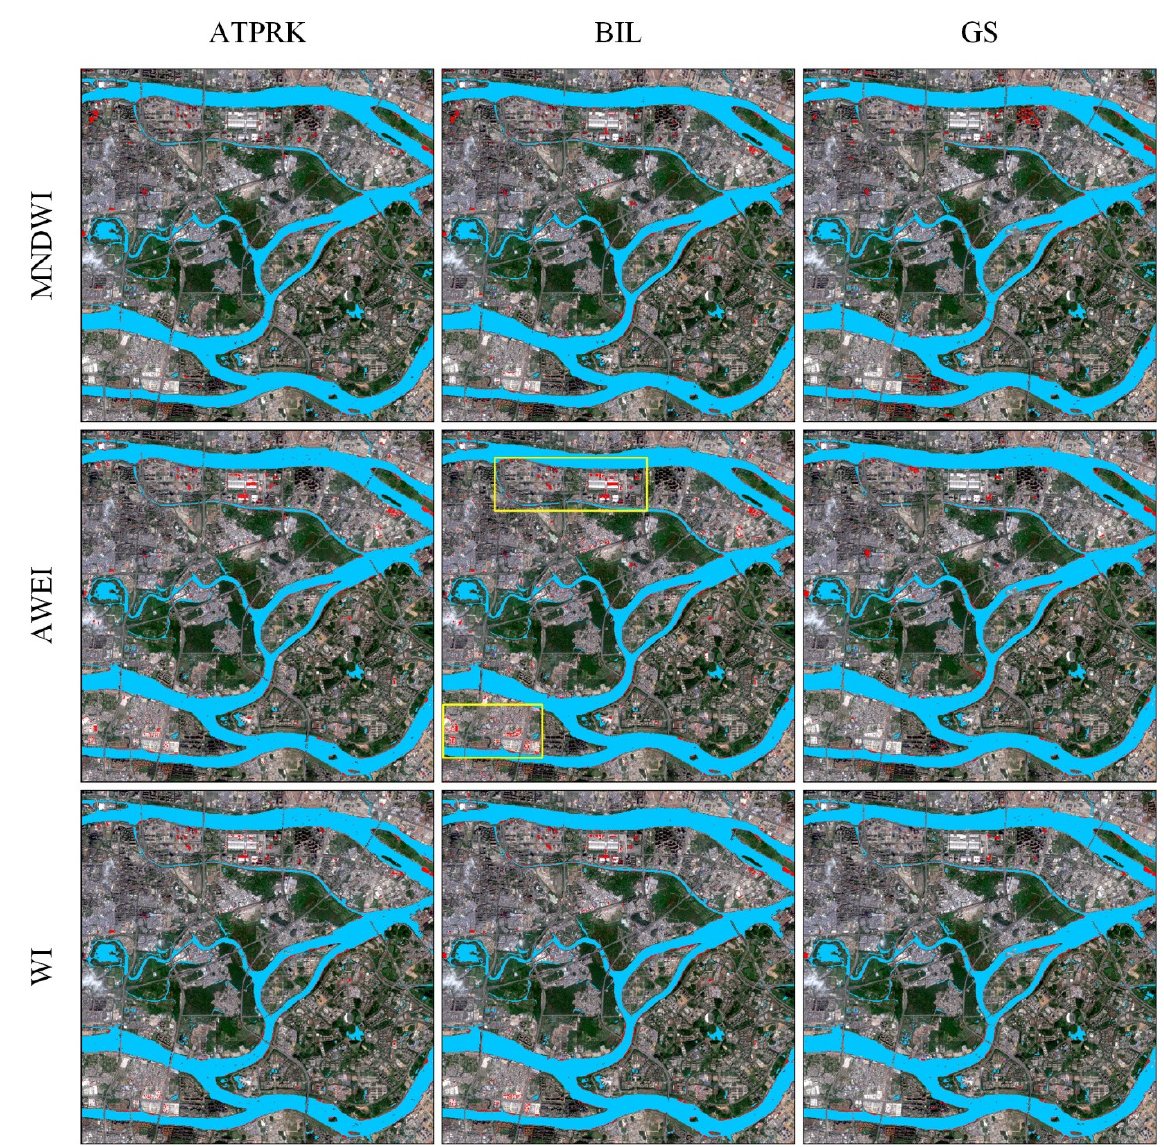
Figure 6. Misclassified results of water bodies for different combinations of water indices and downscaling methods, e.g., misclassification of building shadows in the yellow box.